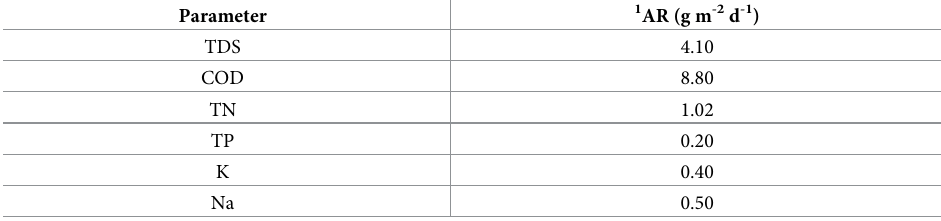
Table 4. Average rates of the synthetic municipal wastewater